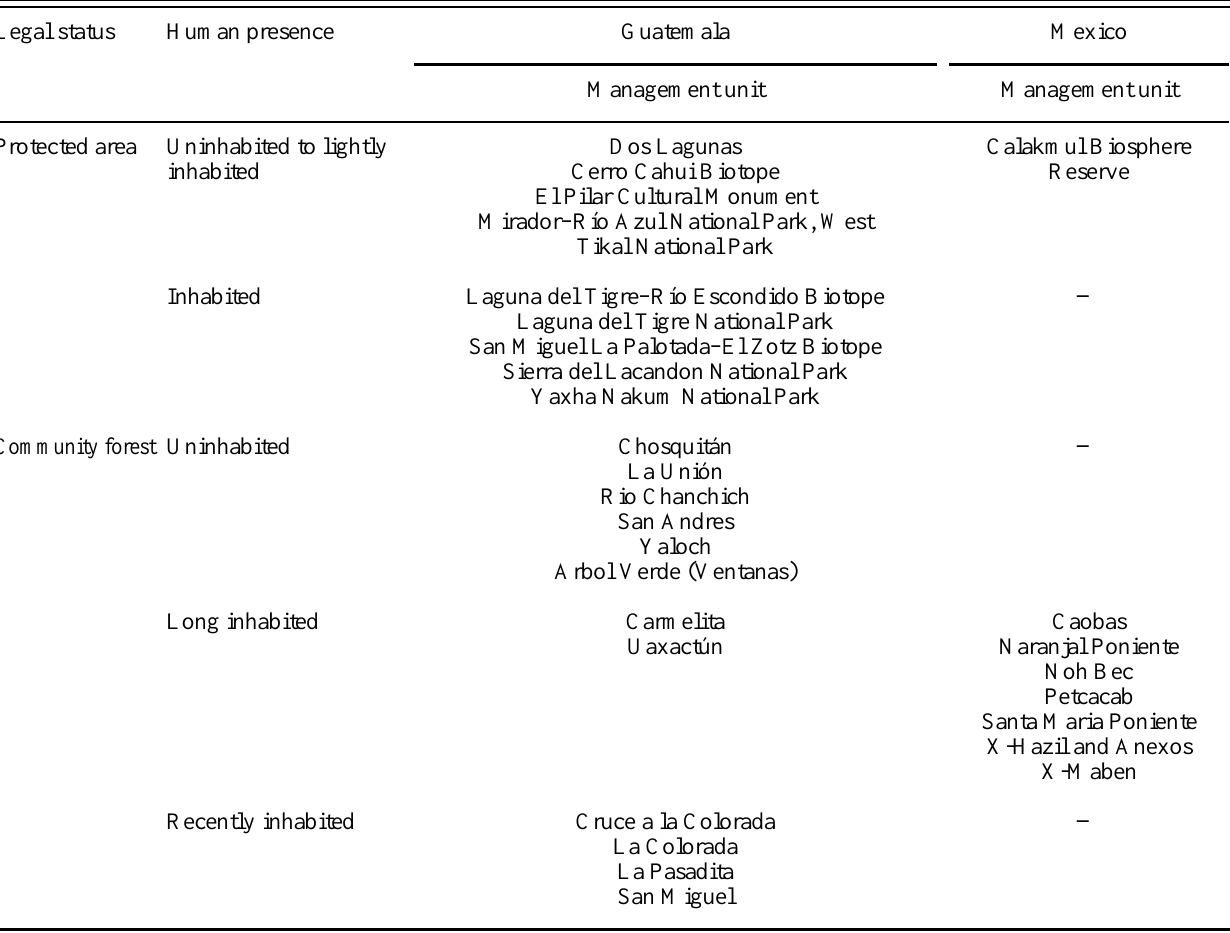
Table 1. Maya Forest protected areas and community forestry management units by legal status, human presence, and